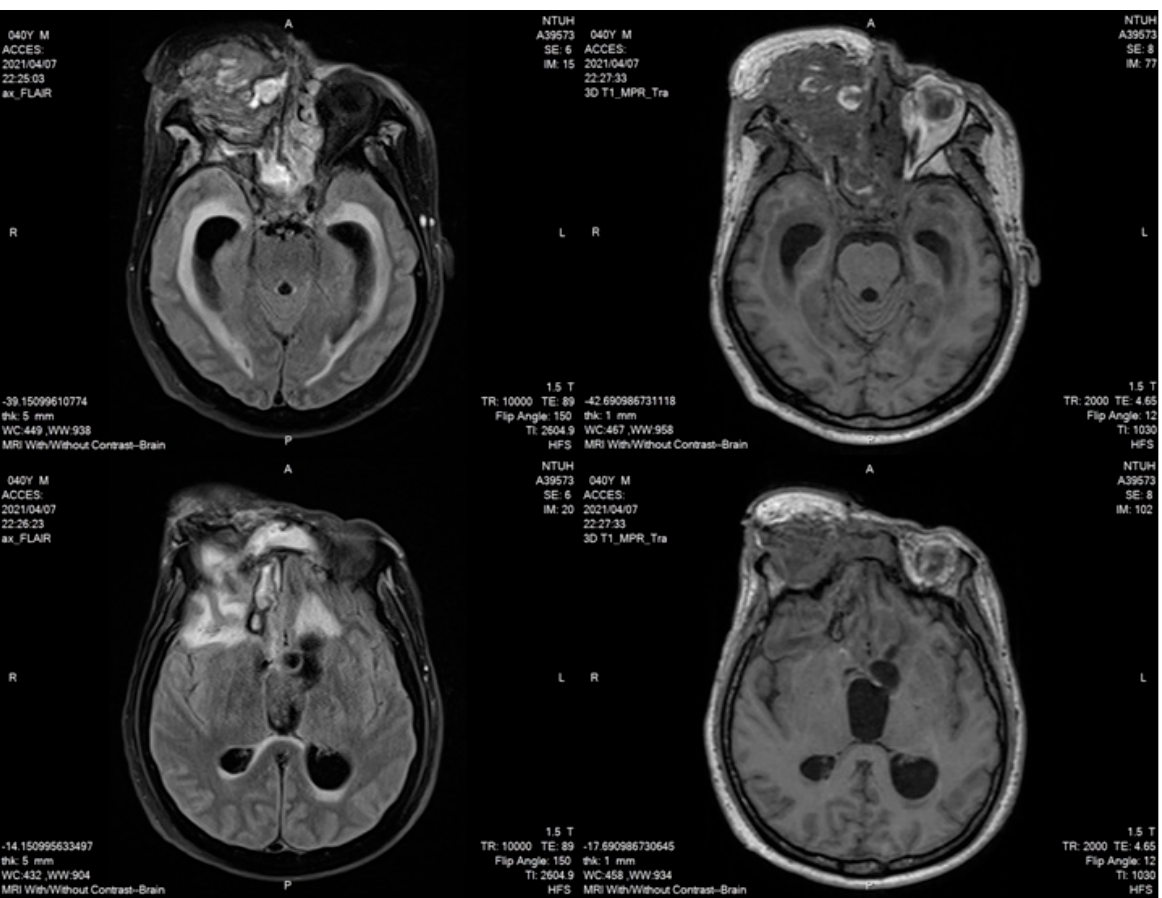
Figure 3. MRI was conducted on 10 April, 2021. Subcortical lesions were resolved at bilateral occipital lobes.